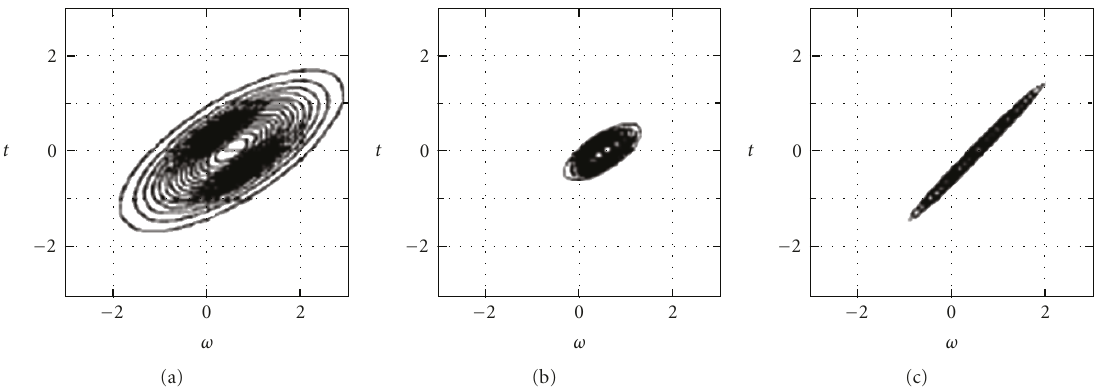
Figure 5: TFD of a Gaussian chirp signal: (a) the WD, (b) the LWD, and (c) the SD distribution with L = 8 (adopted from Stankovi´c